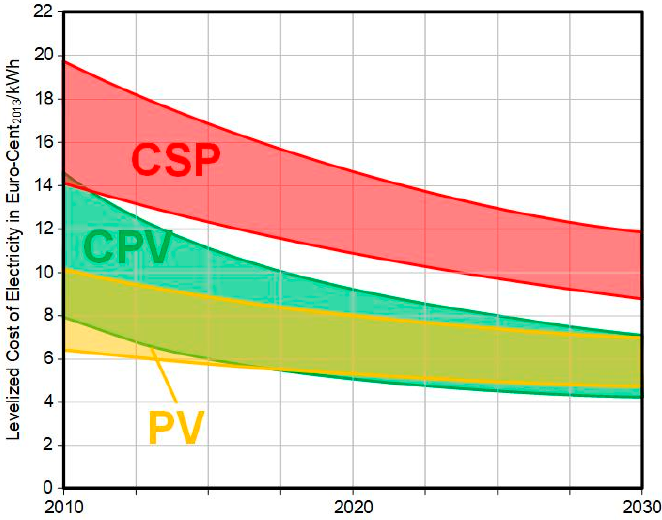
Figure 7. Past development and prognosis of the levelized cost of electricity of PV, concentrated solar power (CSP), and concentrator photovoltaics (CPV) systems in regions of high direct normal irradiance (DNI) (2000 kWh / (m 2 a)–2500 kWh / (m 2 a)). Data based on [35].